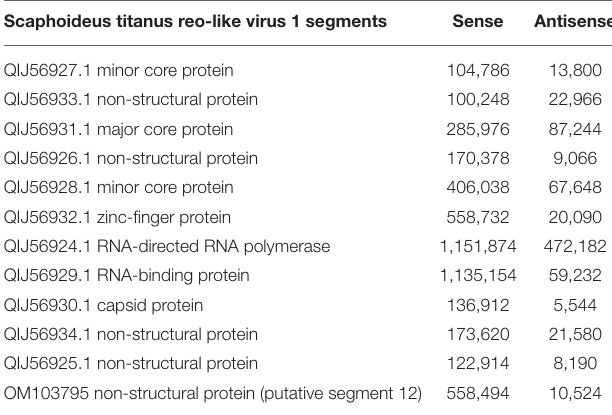
TABLE 3 | Reads that mapped to the 12 segments of Scaphoideus titanus reo-like virus 1 in sense or antisense orientation. Scaphoideus titanus reo-like virus 1